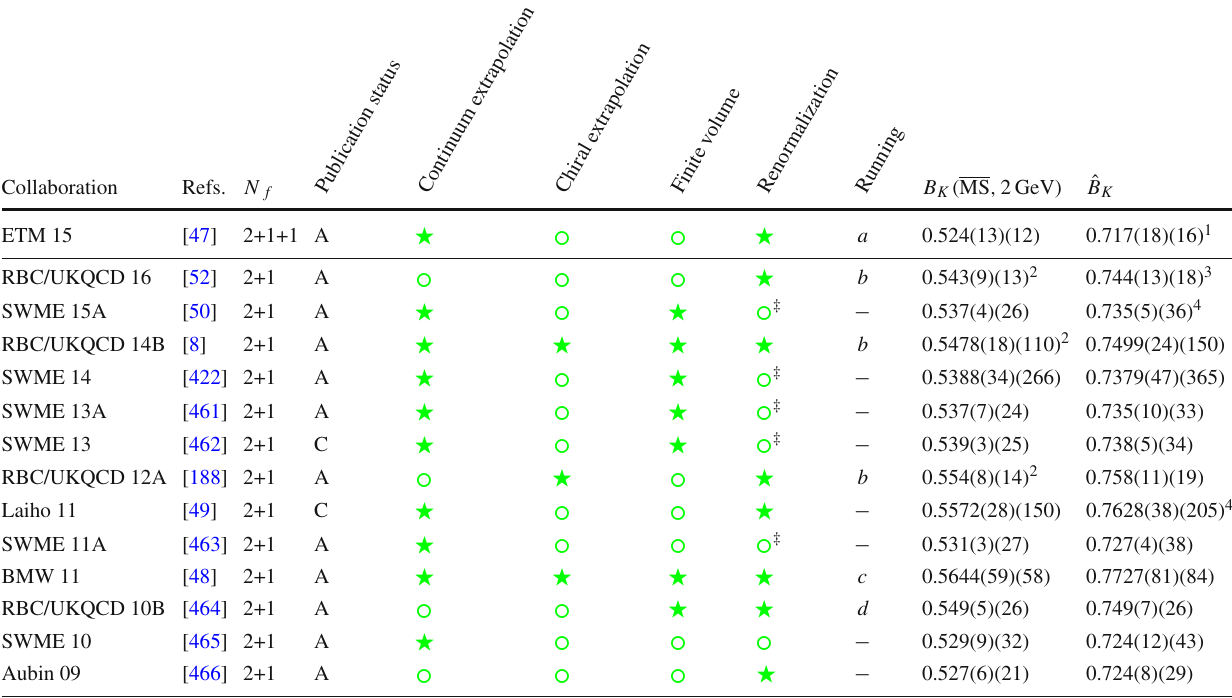
Table 31 Results for the kaon B -parameter in QCD with N f = 2 + 1 + 1 and N f = 2 + 1 dynamical flavours, together with a summary of systematic errors. Information about nonperturbative running is indicated in the column “running”, with details given at the bottom of the table